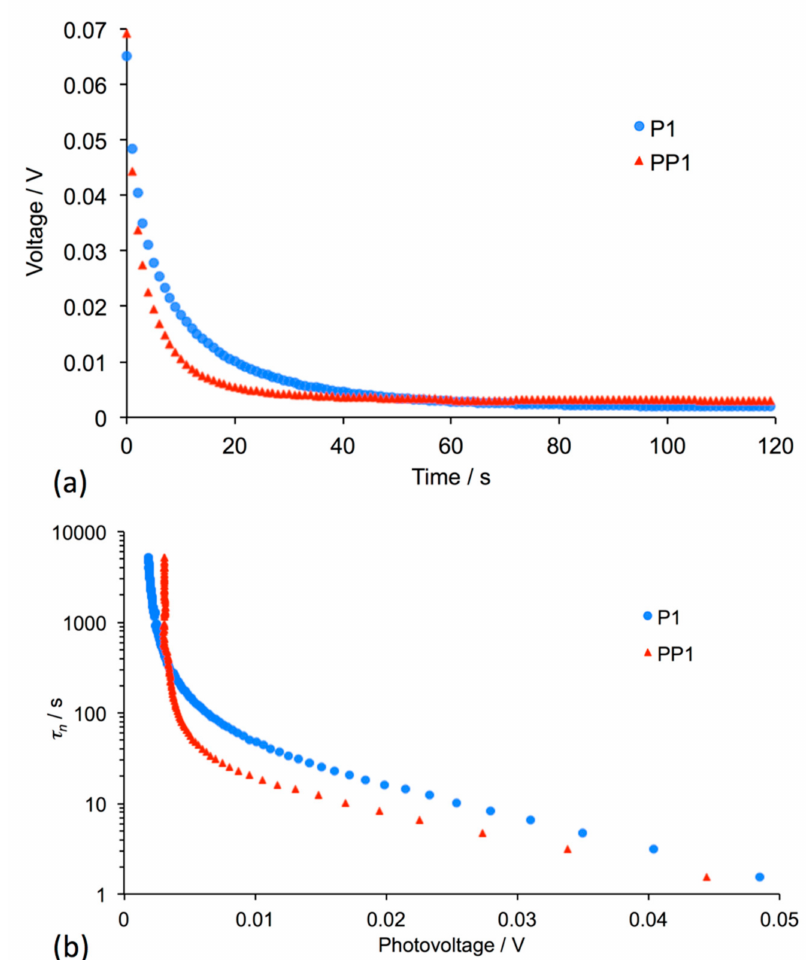
Figure 10. ( a ) Open-circuit voltage decay versus time. ( b ) Electron life time versus open circuit voltage at a light intensity of 22 mW cm − 2